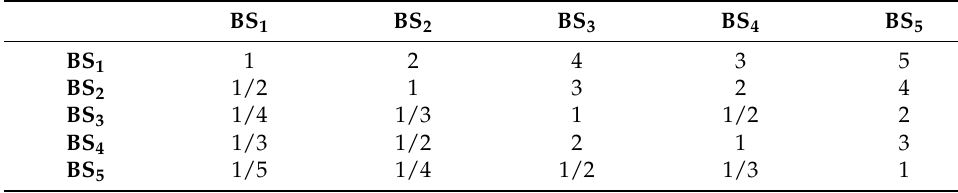
Table A12. The pairwise comparison matrix User _ C 5 .